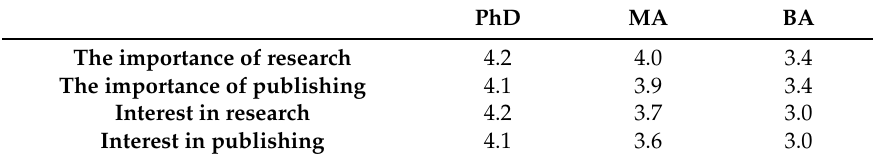
Table 2. Mean scores of the importance and interest in research and publishing across qualifications.